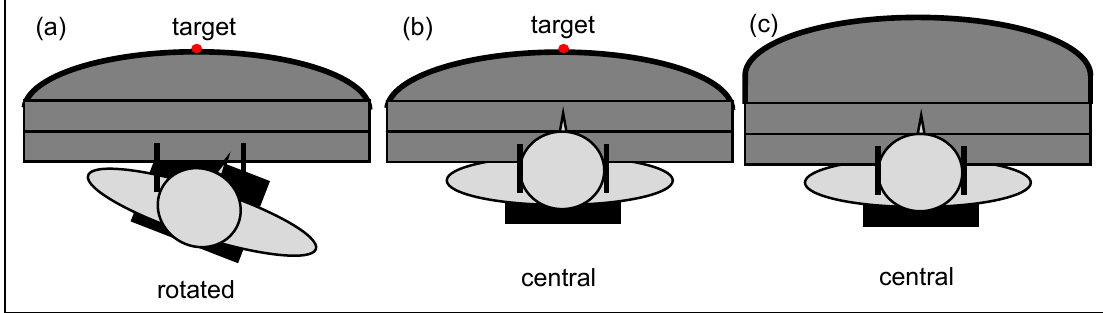
Figure 8. Chair positions: ( a ) prism shift and chair rotation to the right with terminal feedback; ( b ) prism shift to the right and central chair position with terminal feedback; ( c ) central chair with the table extended, hence no visual feedback.